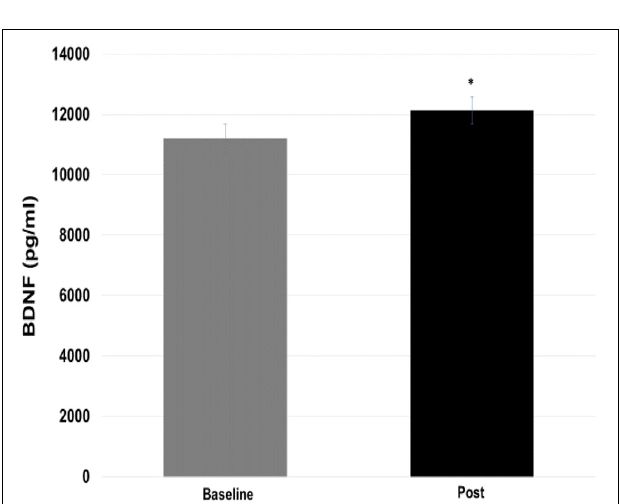
FIGURE 6 | Comparison of brain-derived neurotrophic factor (BDNF) values at baseline and post-training moments. ∗ p = 0.05 vs baseline.